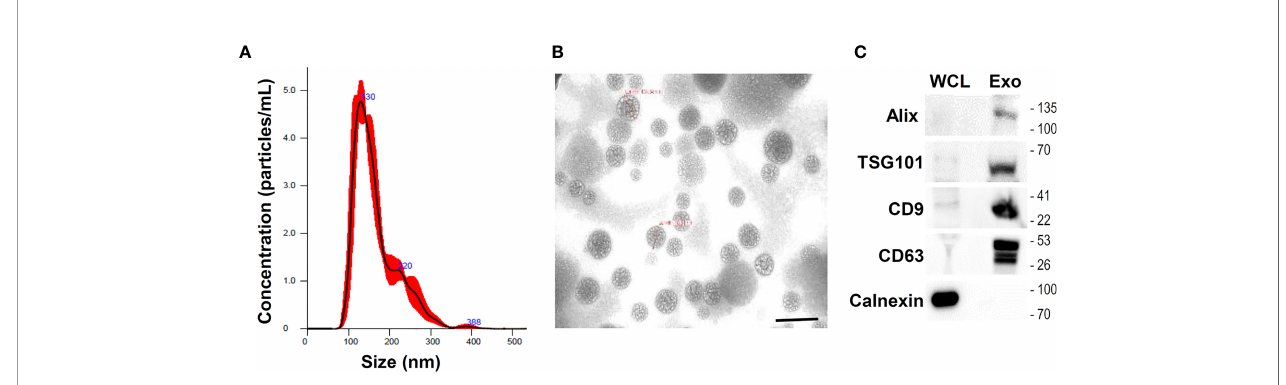
FIGURE 1 | Isolation and characterization of umbilical cord mesenchymal stem cells (UCMSCs)-derived exosomes (U-exo). UCMSCs were cultured in medium containing exosome-depleted FBS for 48 h and culture supernatant was collected and centrifuged at 300×g for 10min to remove cellular debris and 0.22 m m fi ltration using syringe was used to discard small particles including apoptotic bodies. Subsequently, conditioned medium (CM) was collected and exosome was isolated using Exo-spin precipitation and size exclusion chromatography puri fi cation method. (A) Nanoparticle tracking analysis of exosomes isolated and puri fi ed from UCMSCs. The mean diameter of the isolated exosomes was measured to be under 150 nm, indicative of the majority of extracellular vesicles (EVs) being exosomes. (B) Transmission electron microscopy of U-exo at 70,000x magni fi cation. Scale bar =200 nm (C) Immunoblot analysis of U-exo markers (Alix, TSG101, CD9, and CD63) is shown. Calnexin (Endoplasmic reticulum marker) was used as a negative control. WCL: whole cell lysates; Exo: